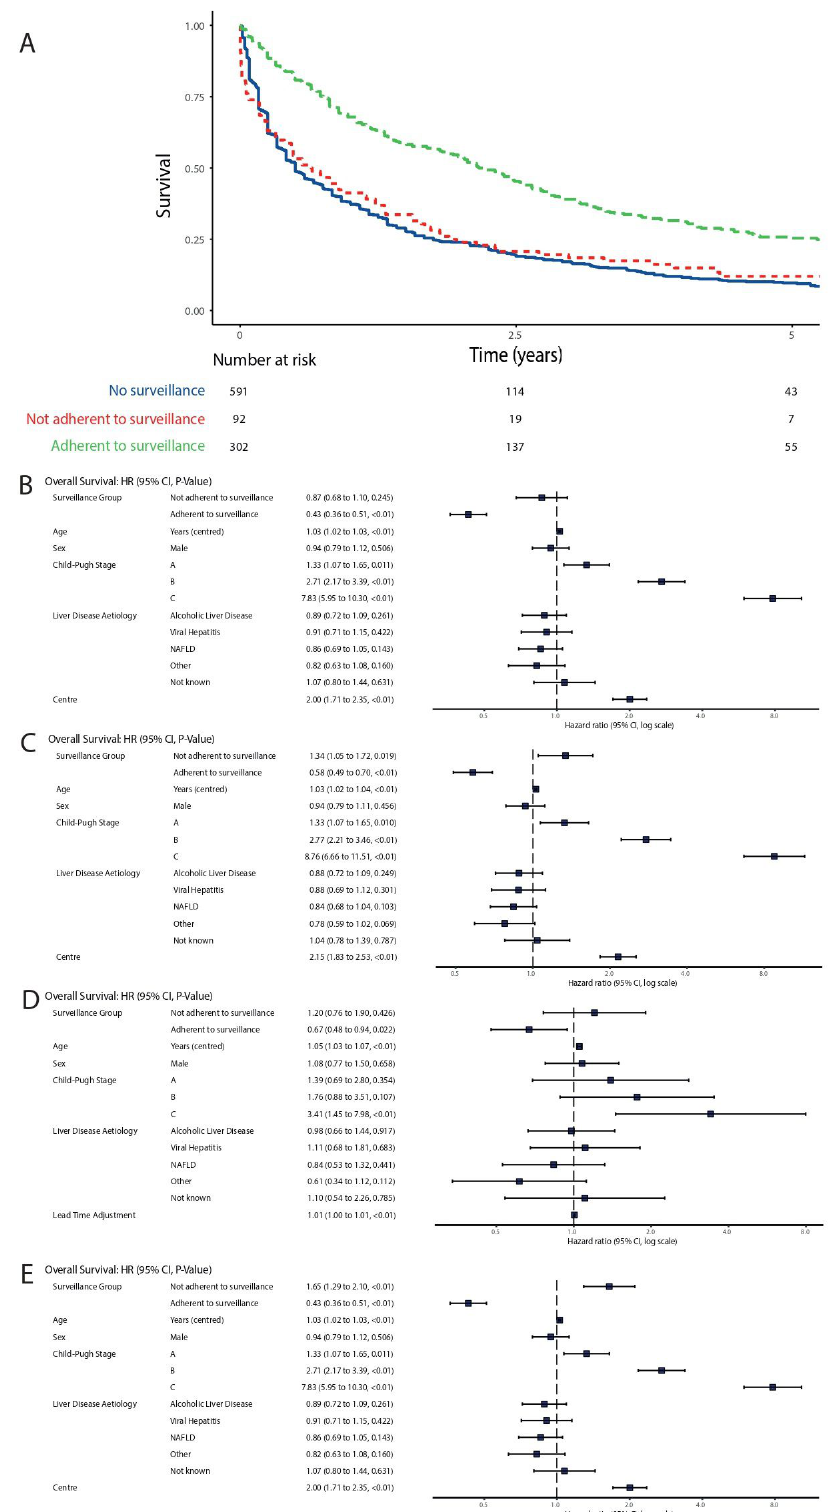
Figure 2. Corrections for lead-time bias. ( A ) Overall survival by surveillance adherence, without adjustment for lead-time, ( B ) flexible parametric survival model for overall survival with no adjustment for lead-time bias, ( C ) flexible parametric survival model for overall survival, adjusted for lead-time bias using rate of transition to symptomatic disease method (270 days), ( D ) flexible parametric survival model for overall survival, adjusted for lead-time bias using tumour size method, ( E ) flexible parametric survival model for overall survival, adjusted for lead-time bias using counterfactual